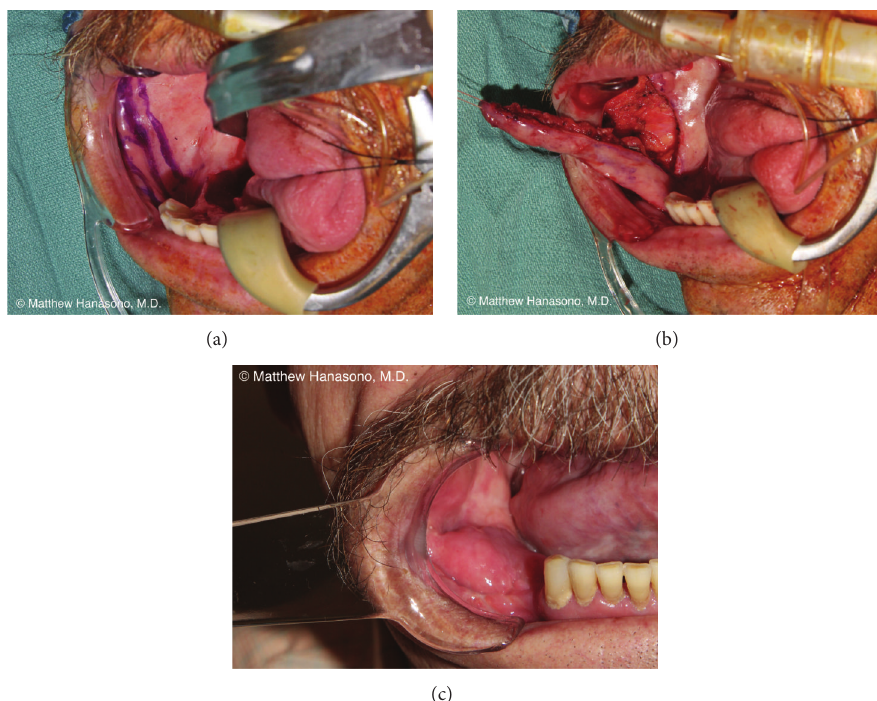
Figure 8: Design of a facial artery musculomucosal pedicled flap for a lateral floor of mouth and mandibular gingival defect (a). The flap is elevated and includes a portion of the buccinator muscle and the facial artery, which is deep to the muscle (b). Postoperative appearance